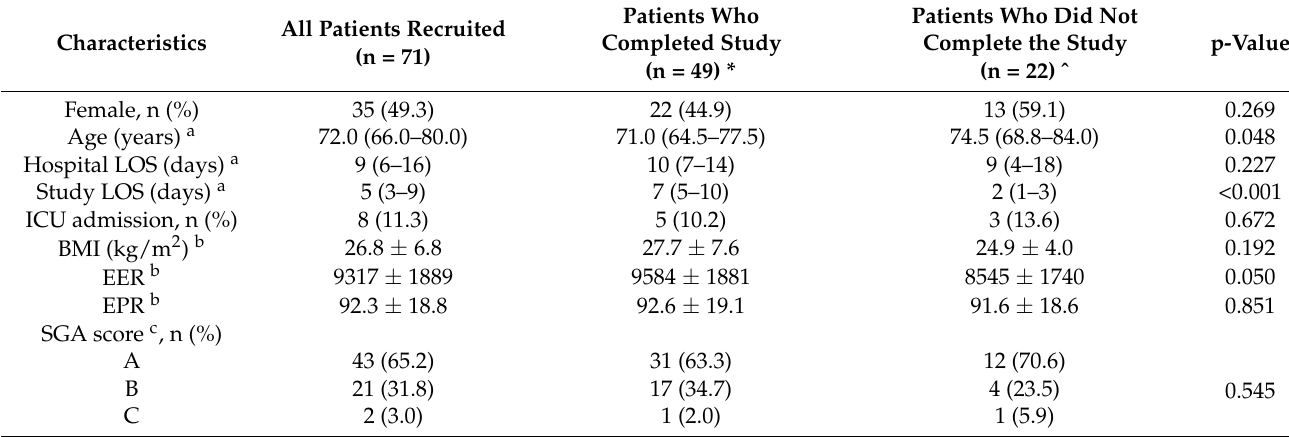
Figure 3. Participant flow diagram. Table 1. Participant characteristics.